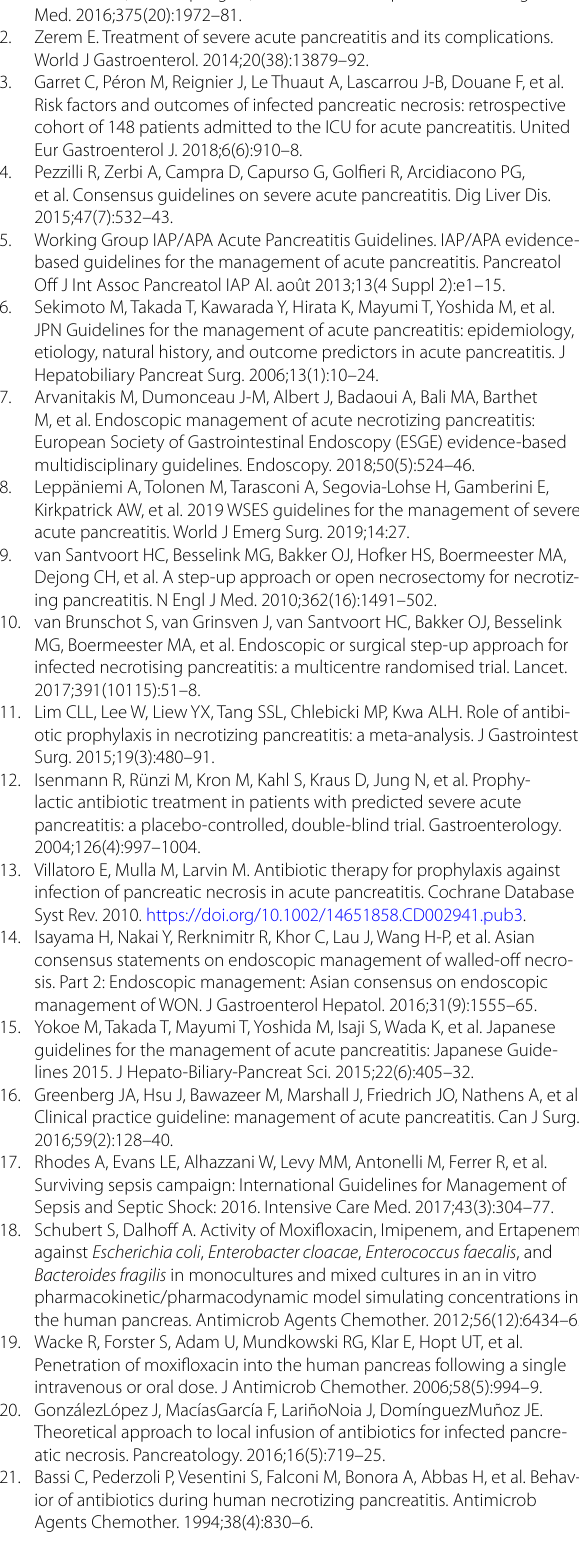
Additional file 1: Table S1 . Modified Marshall scoring system for organ dysfunction. Additional file 2: Table S2. Microbiological culture results in 23 patients with infected pancreatic necrosis and multidrug‑resistant (MDR) or exten‑ sively drug‑resistant (XDR) bacteria in pancreatic samples. Additional file 3: Table S3. Details of antibiotic therapy and micro‑ biological results of pancreatic samples in 10 patients with extensively drug‑resistant bacteria during their hospital stays for infected pancreatic